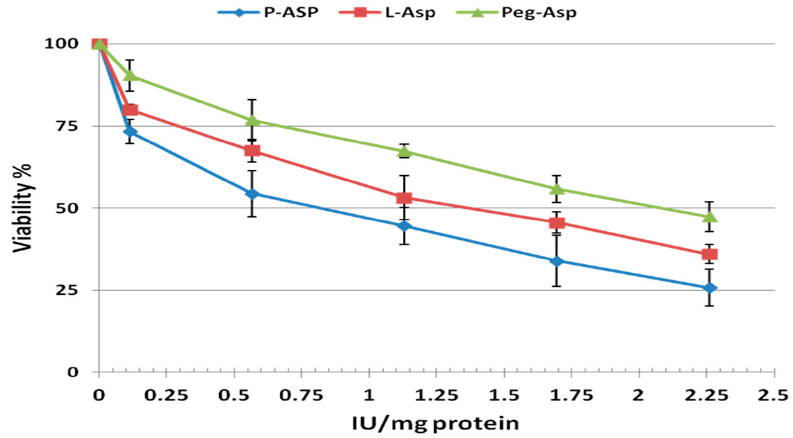
Figure 1. WST-8 assay for cell viability of Jurkat cells after treatment with adjusted doses of enzyme preparations according to their specific activity.